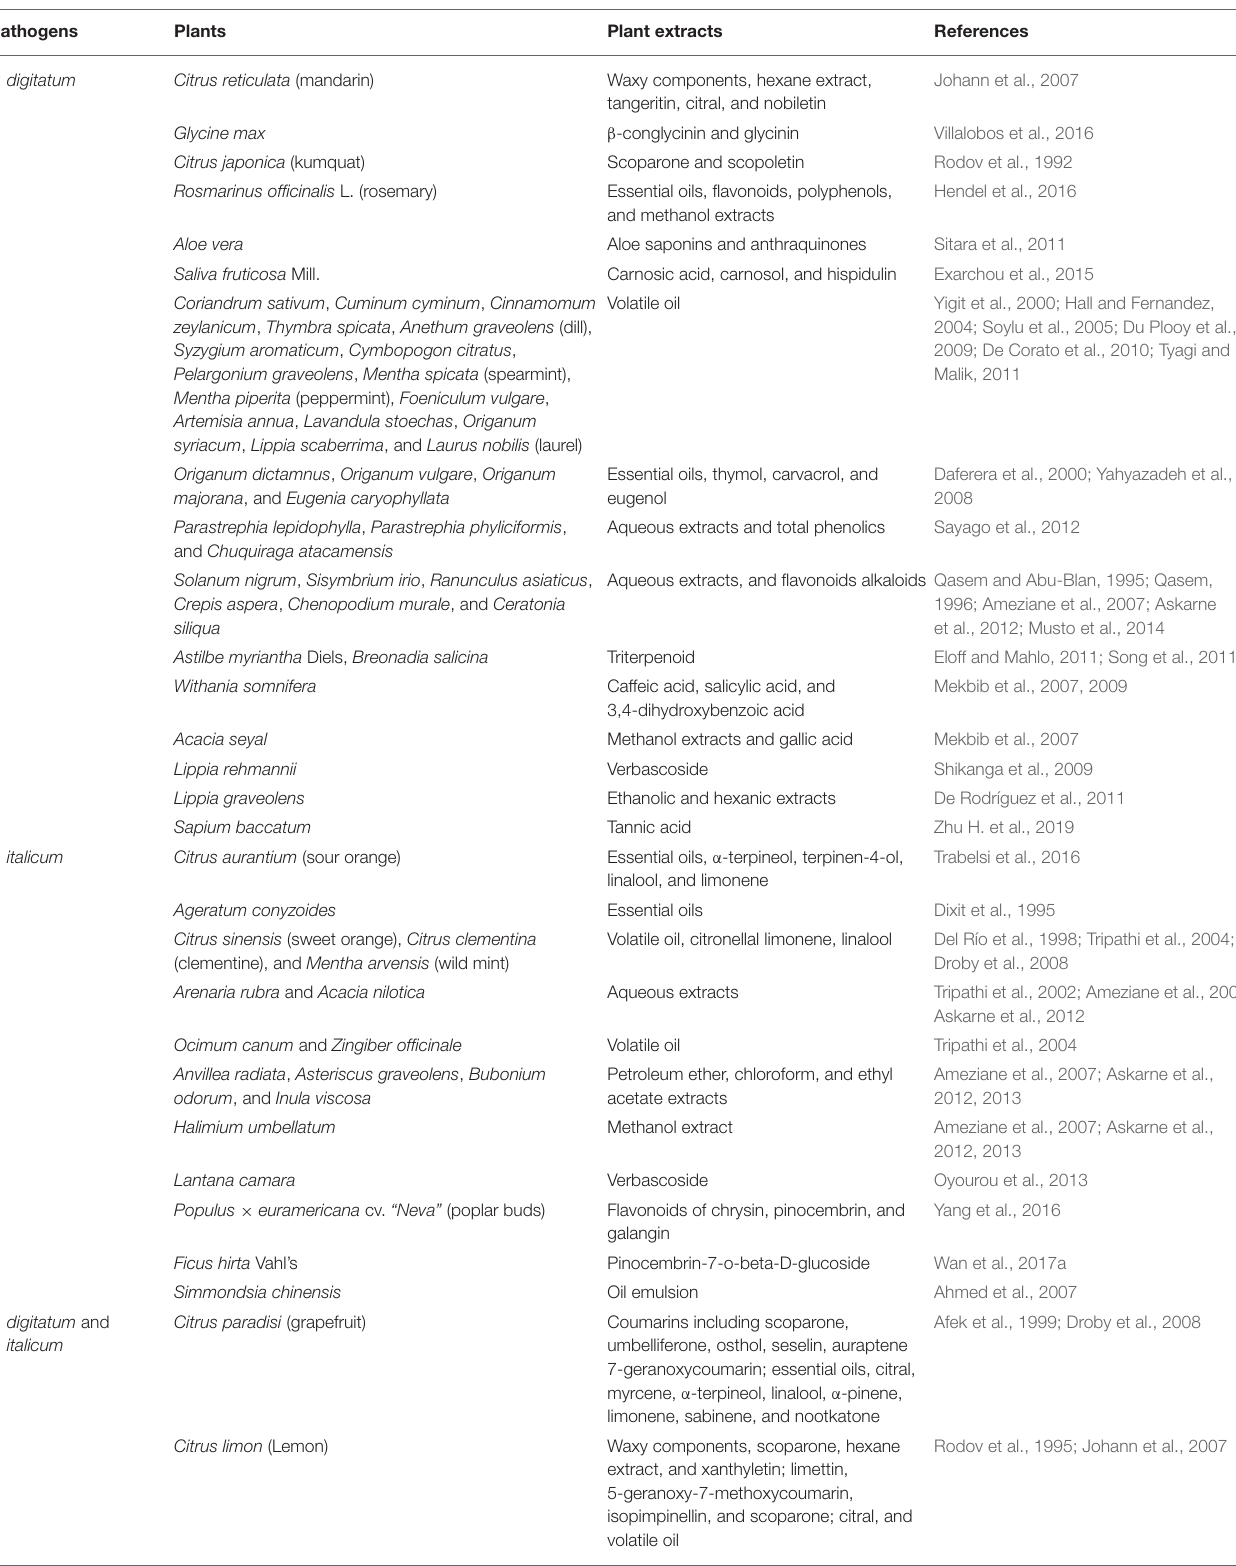
TABLE 2 | Plant extracts, essential oils, and natural compounds for the control P. digitatum and P. italicum .